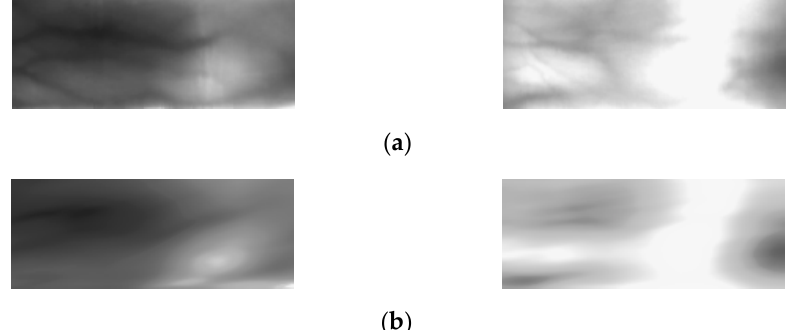
Figure 9. Examples of original images and motion blurred images of SDU-DB. ( a ) Original images; ( b ) motion blurred images.